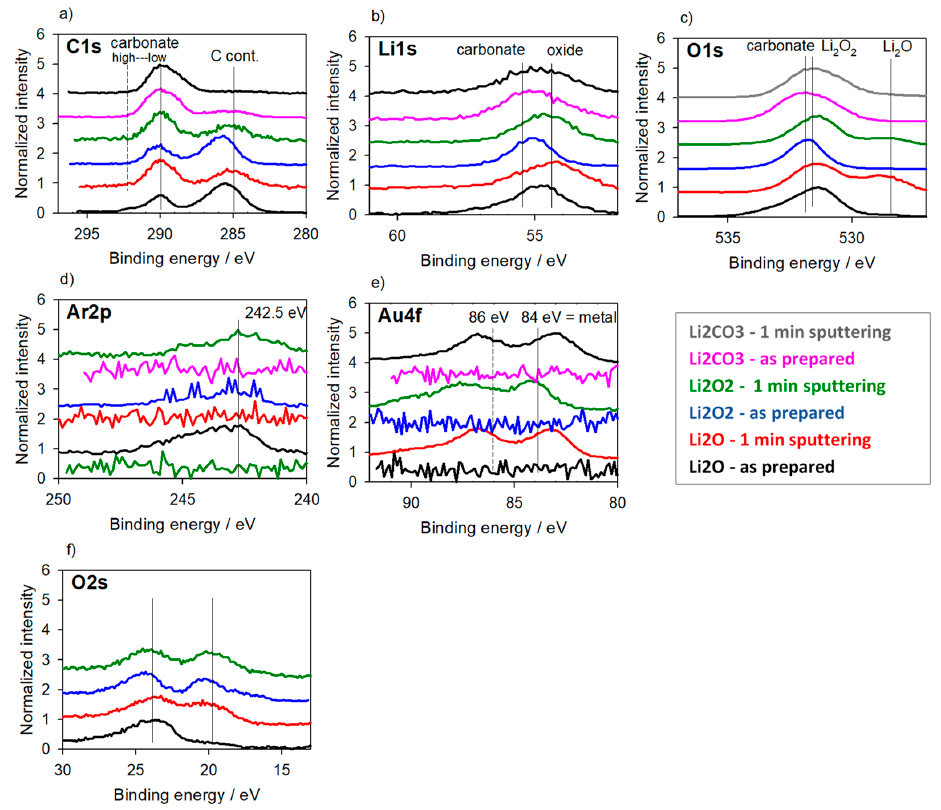
Figure 11. XP spectra normalized in intensity of pure and shortly sputtered powders of Li 2 O, Li 2 O 2 and Li 2 CO 3 ( bottom to top ) normalized in BE to carbonate C1s at 290 eV. Ar2p and Au4f are found at standard low energies (242.5 and 84 eV). ( a ) C1s; ( b ) Li1s; ( c ) O1s; ( d ) Ar2p; ( e ) Au4f; ( f ) O2s transition.